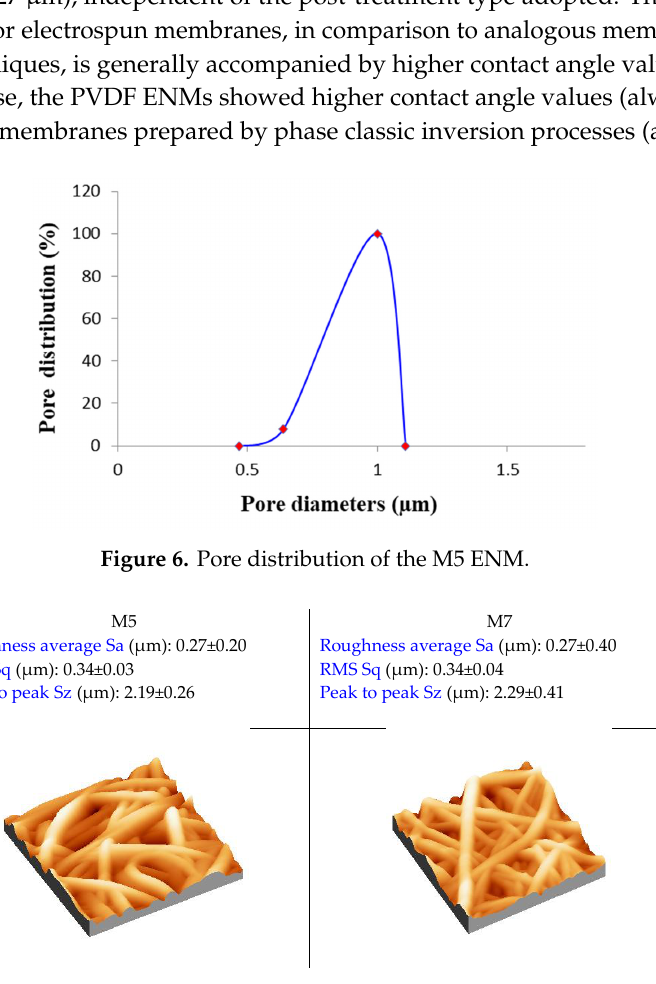
Figure 7. Atomic force microscopy (AFM) pictures of the PVDF ENMs and the values of roughness for M5 and M7 .